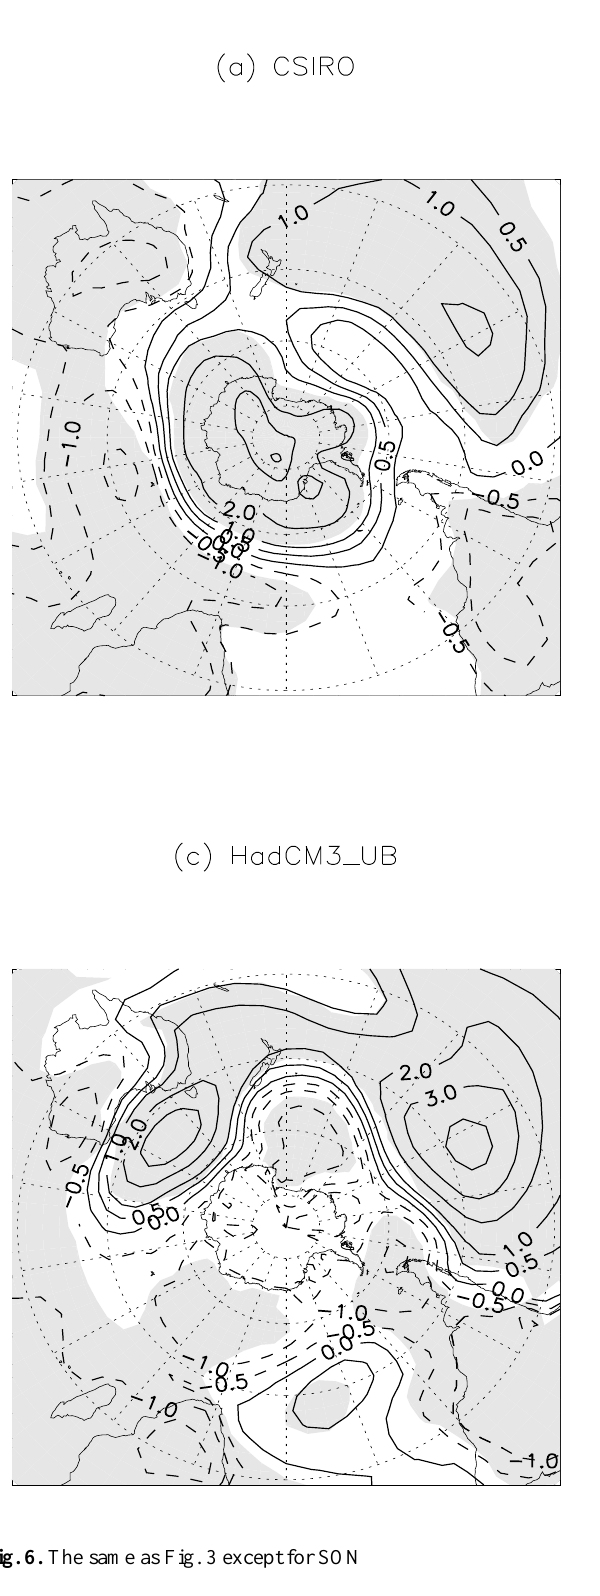
www.clim-past.net/7/1189/2011/ Clim. Past, 7, 1189–1207,